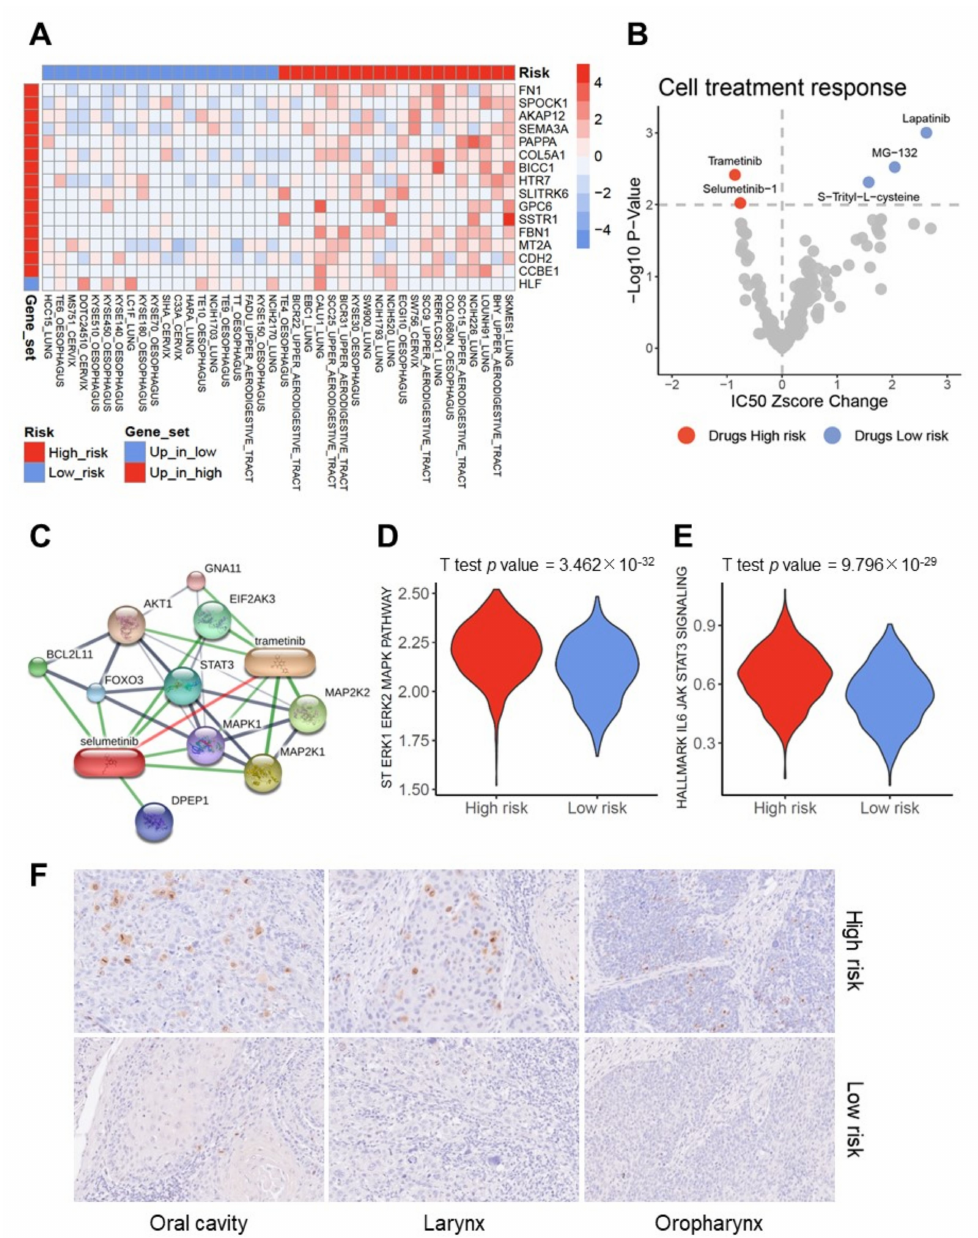
Figure 6. MEK inhibitors as potential drugs for high-risk SCC. ( A ) Heatmap demonstrates expression pattern of 16 survival-related candidate genes in indicated cancer cell lines with a low-risk or high-risk profile. ( B ) Volcano plot summarizes the relative change in the IC50 z-score and p -value among selected SCC cell lines with a low-risk or high-risk profile, which were treated with indicated compounds based on the Genomics of Drug Sensitivity in Cancer (GDSC) database. Red dots represent drugs with a significantly higher sensitivity for high-risk SCC cell lines and blue dots represent drugs with a significantly higher sensitivity for low-risk SCC cell lines. ( C ) Schematic presentation of a protein–protein and protein–chemical association network (minimum required interaction score: medium confidence (0.400)) for Trametinib and Selumetinib based on the STITCH database. ( D , E ) Violin plots demonstrate significantly higher ssGSEA scores for either ERK-MAPK or JAK-STAT3 signaling pathways in high-risk as compared to low-risk groups of the pan-SCC cohort. ( F ) Representative pictures of an IHC staining demonstrates prominent MEK1/2 phosphorylation (brown signal) in cancer cells of high-risk (upper row) but not in low-risk (lower row) HNSCC of the indicated subsites. Histological staining with hematoxylin to visualize the tissue